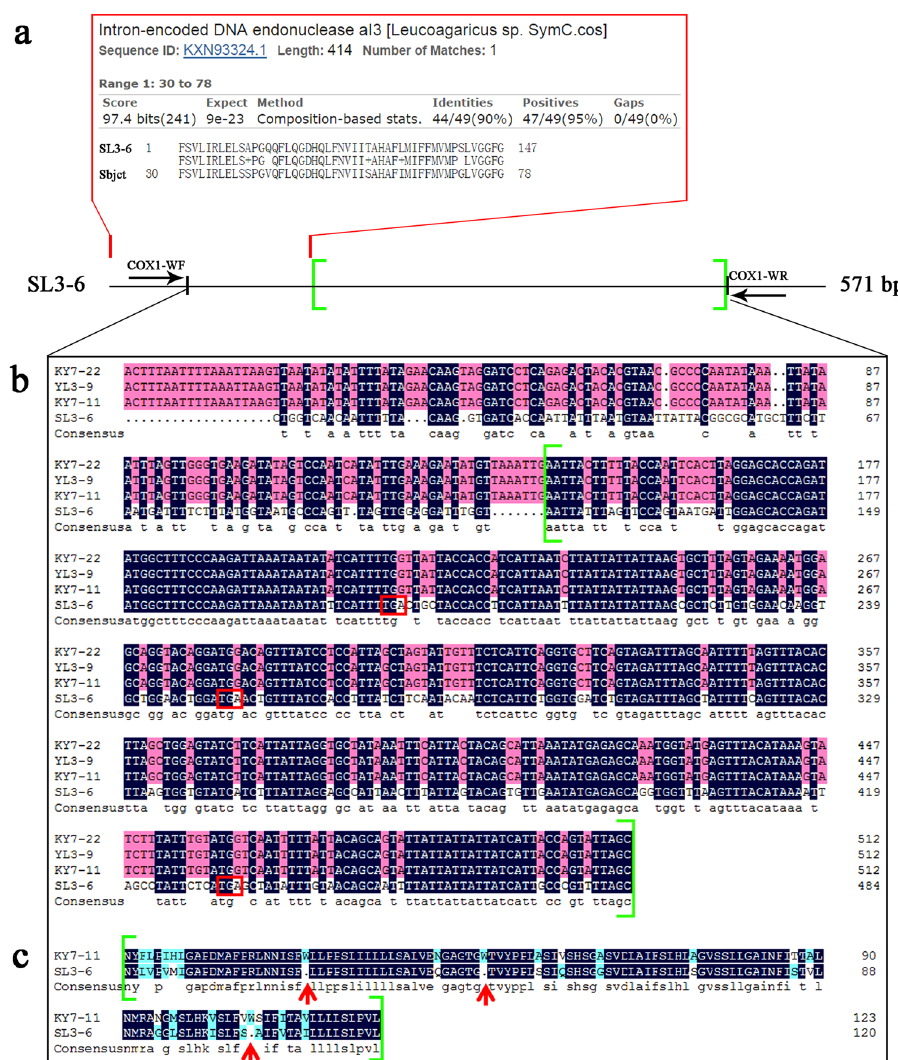
Figure 2. The nucleotide sequence features of the initial COX1 fragment of strain SL3-6 and the nucleotide and translated amino acid sequence alignments of the representative types of COX1 fragments. ( a ) The 5 ′ end sequence (red region) showed a match with intron-encoded DNA endonuclease aI3 through BLASTx. ( b ) Two type sequences were represented by SL3-6 and KY7-11, YL3-9, KY7-22. We only show the alignment of the matching region of these two type sequences. The sequences for the translated amino acids were restricted to the region marked by a pair of green bracket. Red boxes indicate termination codons. ( c ) The alignment of amino acid sequences of COX1 fragments in the green bracket. Red arrows indicates the location of termination